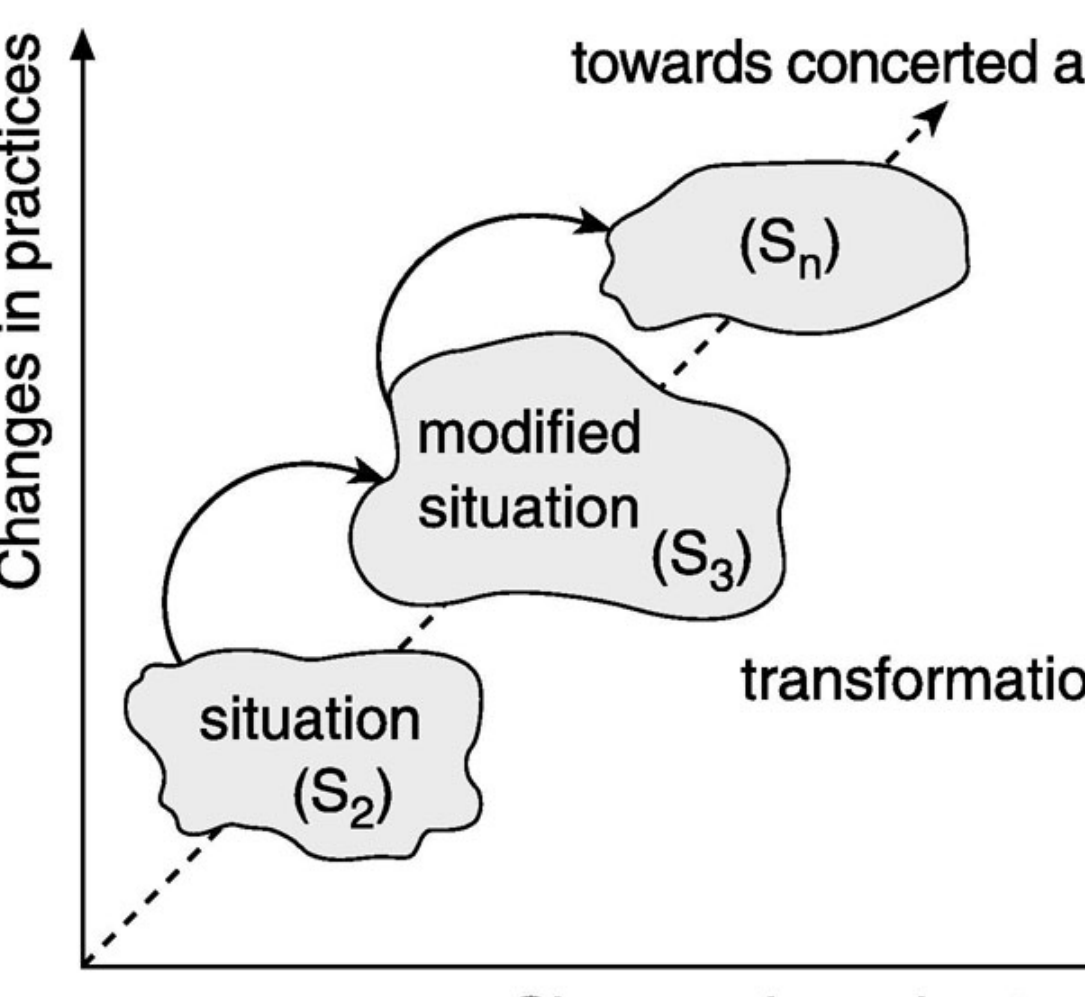
Fig. 1 . Situations of complexity, uncertainty, and conflict associated with water management are transformed through concerted action by stakeholders, who build their stakeholding in the process. This leads to changed understandings, i.e., knowledge in action, and